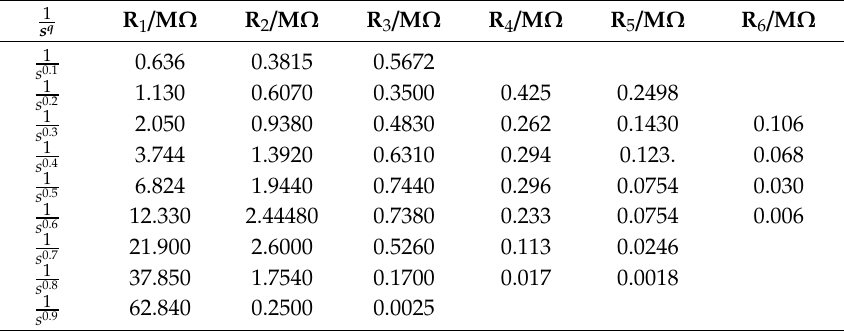
Table 2. Resistance value in q -order fractional unit circuit.